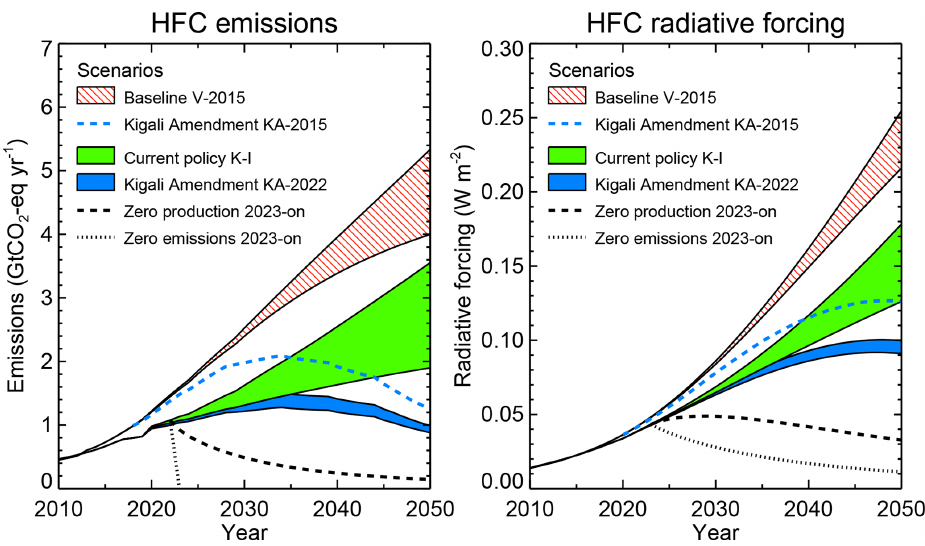
Figure 4. Global total HFC emissions (GtCO 2 eq . yr − 1 ; left panel) and radiative forcing (right panel) from the V-2015 baseline scenarios developed in Velders et al. (2015) and the updated scenarios derived here (current policy Kigali independent (K-I) and KA-2022). The bands represent the upper and lower ranges of these scenarios. Also shown are scenarios that follow the phasedown schedules of the Kigali Amendment, based on the V-2015 baseline, and the current policy K-I scenario. No range is shown for the updated Kigali Amendment scenario (KA-2022), since the lower and upper range scenarios virtually coincide. Also shown are hypothetical scenarios in which the global HFC production ceases in 2023 or the global HFC emissions (from new production and from banks) cease in 2023. The curves contain the contributions of all HFCs, except